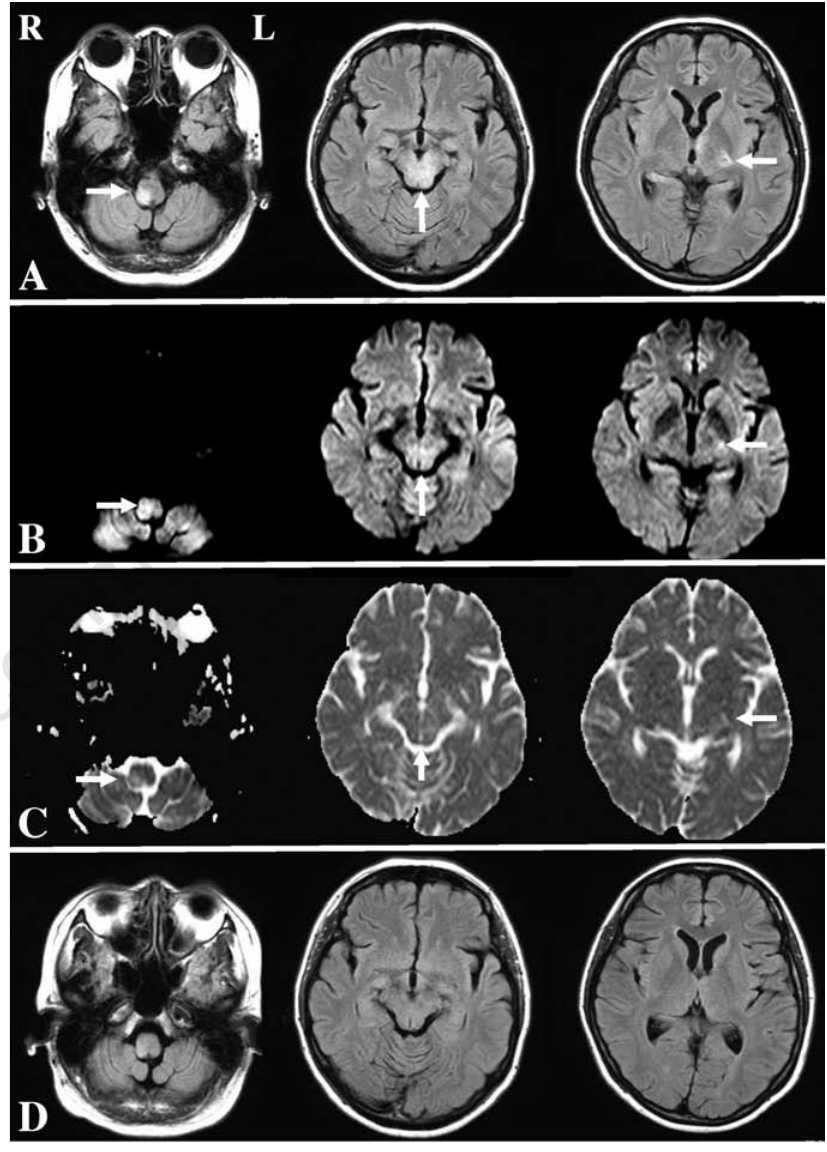
Figure 1. Brain MRI on admission in Case #1. Serial images of axial fluid-attenuated inversion recovery magnetic resonance imaging and diffusion-weighted images showing high-intensity signals in the right dorsal medulla oblongata, bilateral dorsal midbrain, and left thalamus (A and B, arrows). Apparent diffusion coefficient values were increased (C, arrows). Follow-up FLAIR images at 20 days after admission showed that the high- intensity signals in the right dorsal medulla oblongata, bilateral dorsal midbrain, and left thalamus were markedly decreased